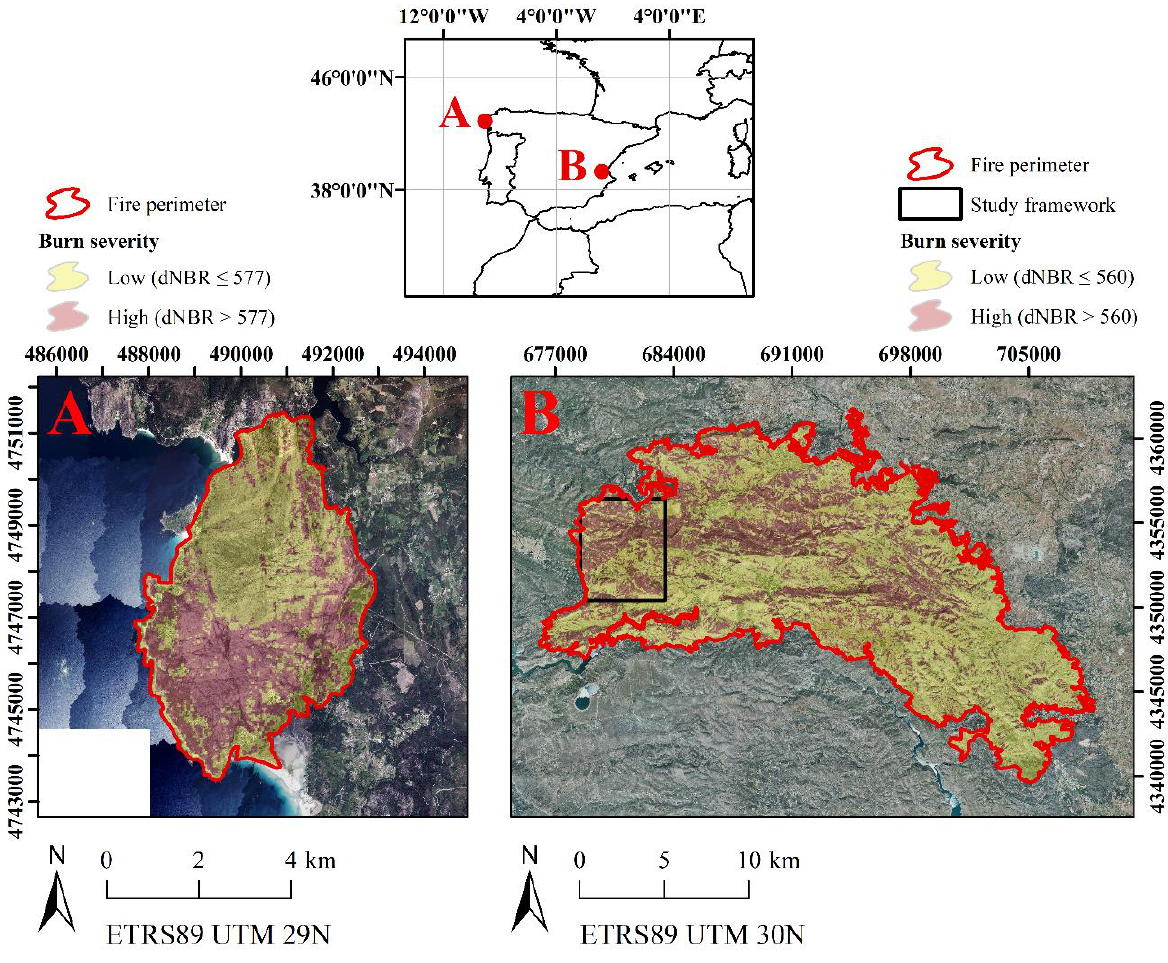
Figure 2. Overview of the Atlantic ( A ) and Mediterranean ( B ) study sites in the Iberian Peninsula and burn severity estimated from the difference of the Normalized Burn Ratio (dNBR). Background imagery correspond to aerial orthophotos of the Spanish Aerial Ortho-photography National Plan (PNOA).